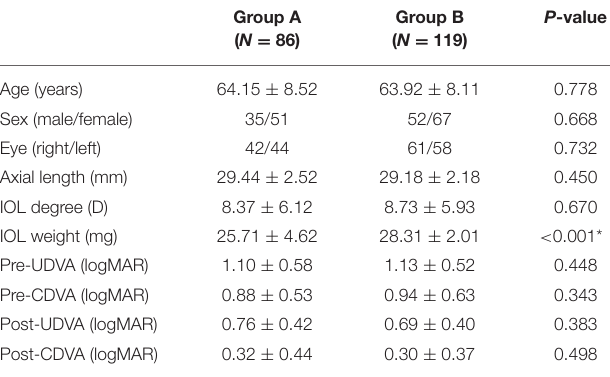
CDVA, Corrected distance visual acuity; D, diopter; IOL, Intraocular lens; logMAR, Logarithm of the minimal angle of resolution; N, Number of eyes; UDVA, Uncorrected distance visual acuity. Data are mean ± SD. * P <